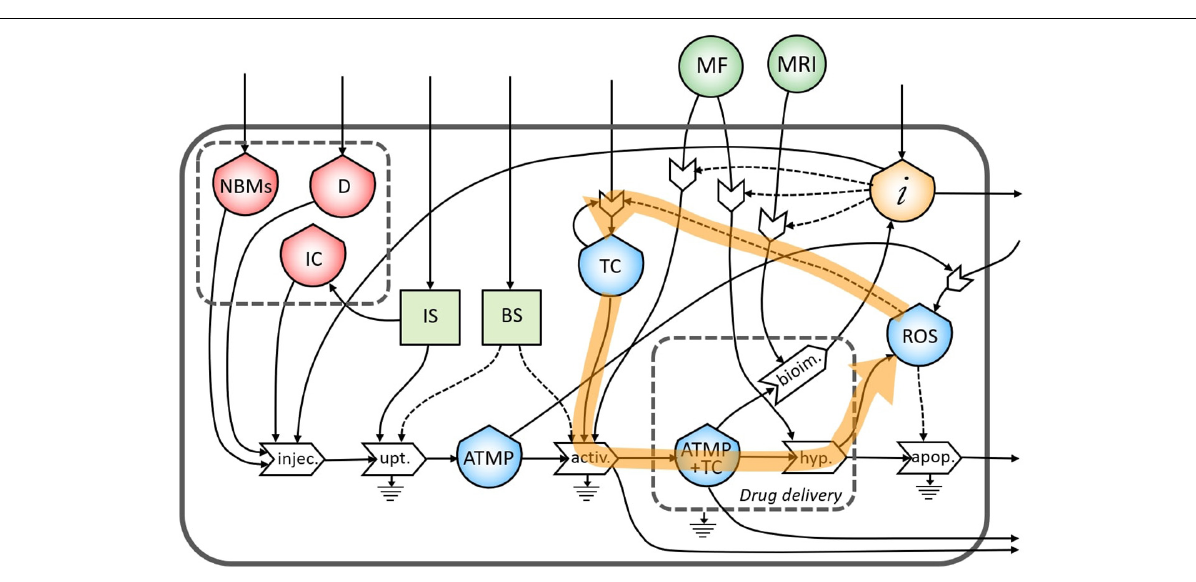
FIGURE 7 | Representation of the feedback loop of the flow of reactive oxygen species (ROS) in the proliferation of